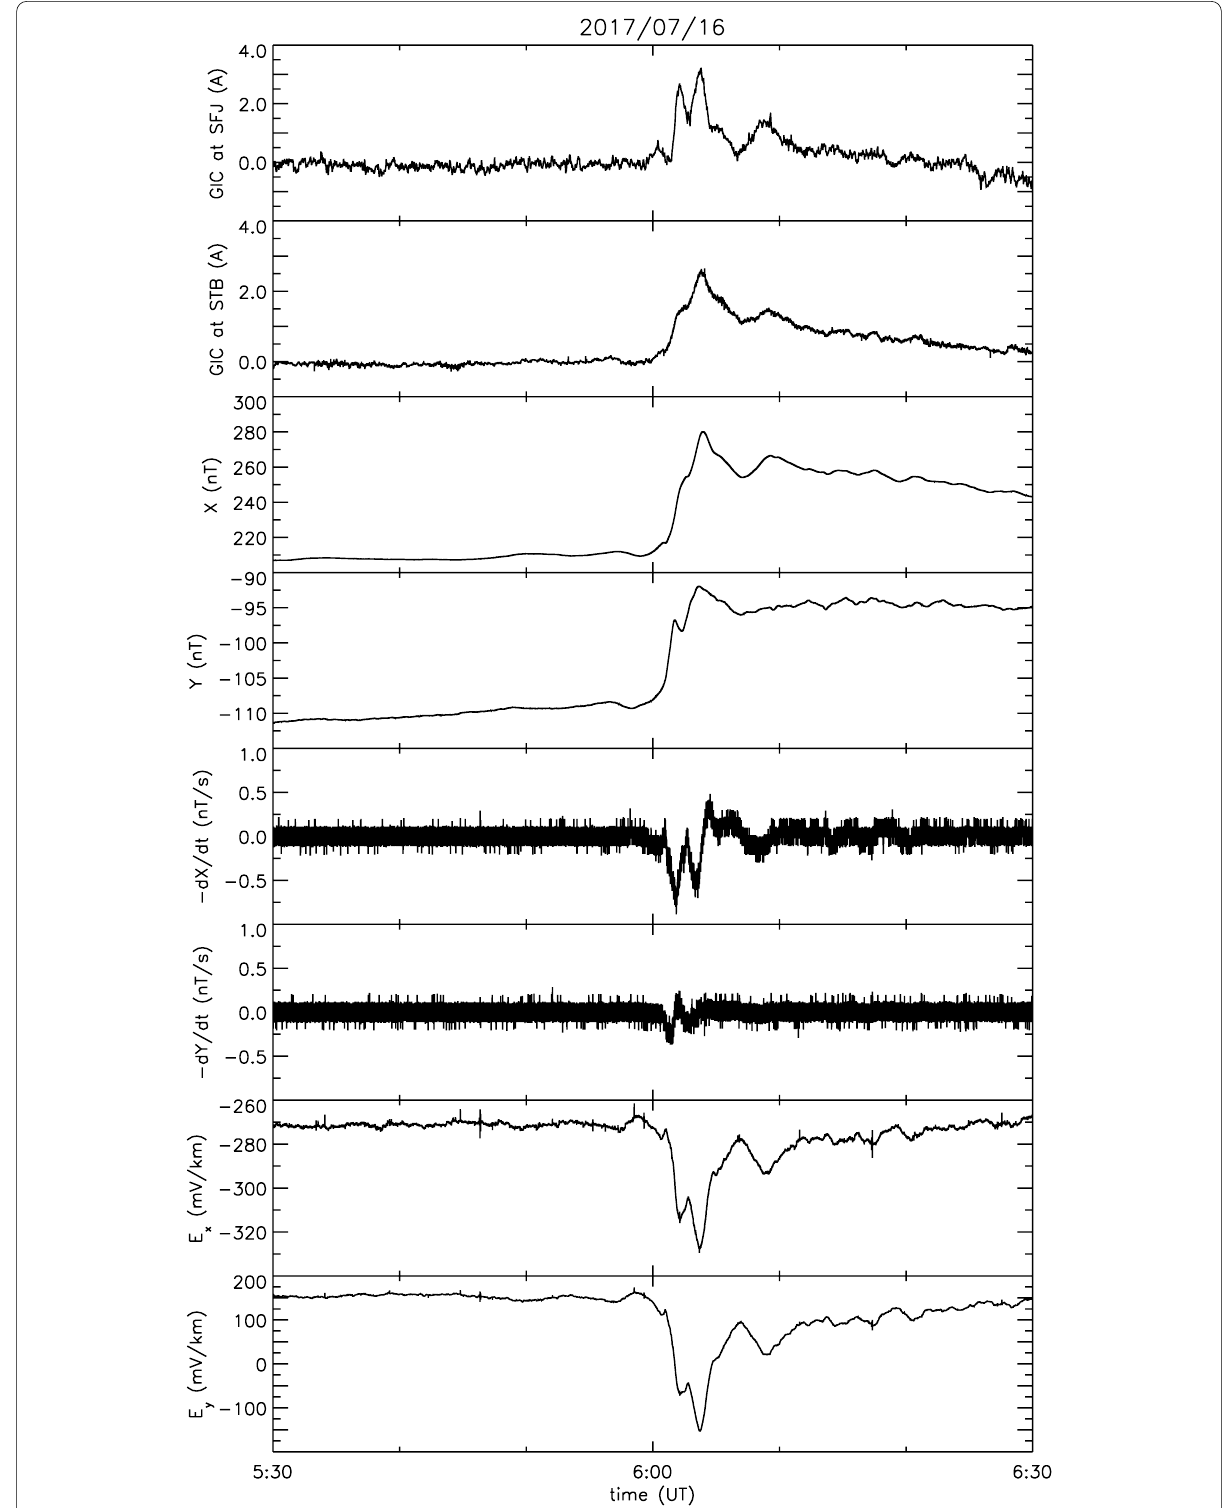
Fig. 5 0.1-s data of X- and Y-components of geomagnetic field at KAK and negative values of their time derivatives, and of X- and Y-components of geoelectric field at KAK associated with the 16 July 2017